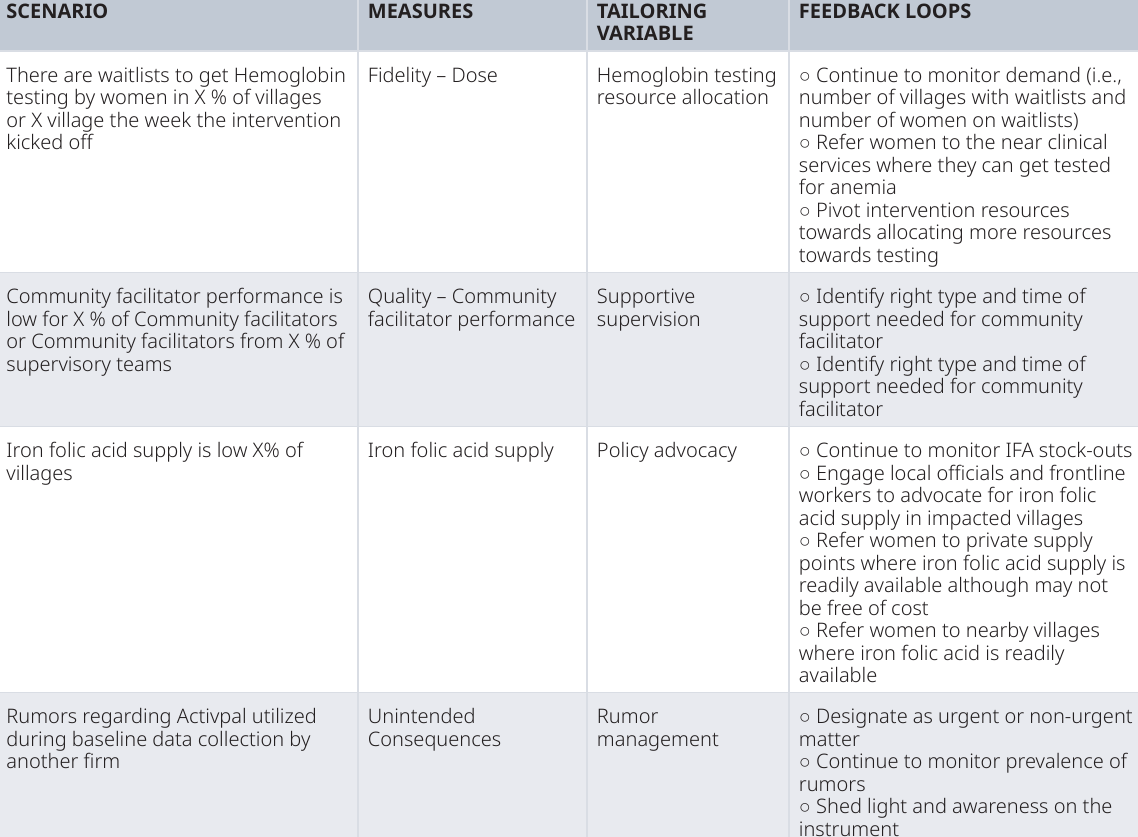
Table 3. Hypothetical Examples of Tailoring Variables and Feedback